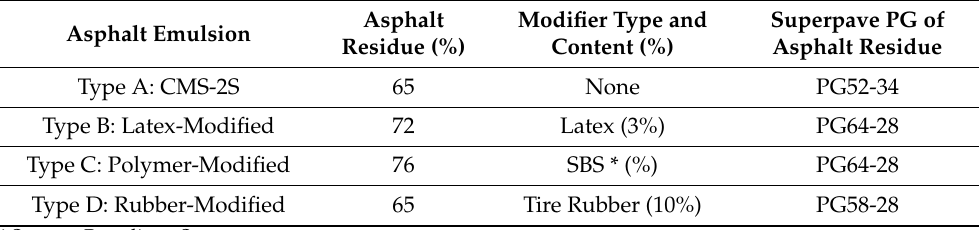
Table 1. Properties of Asphalt